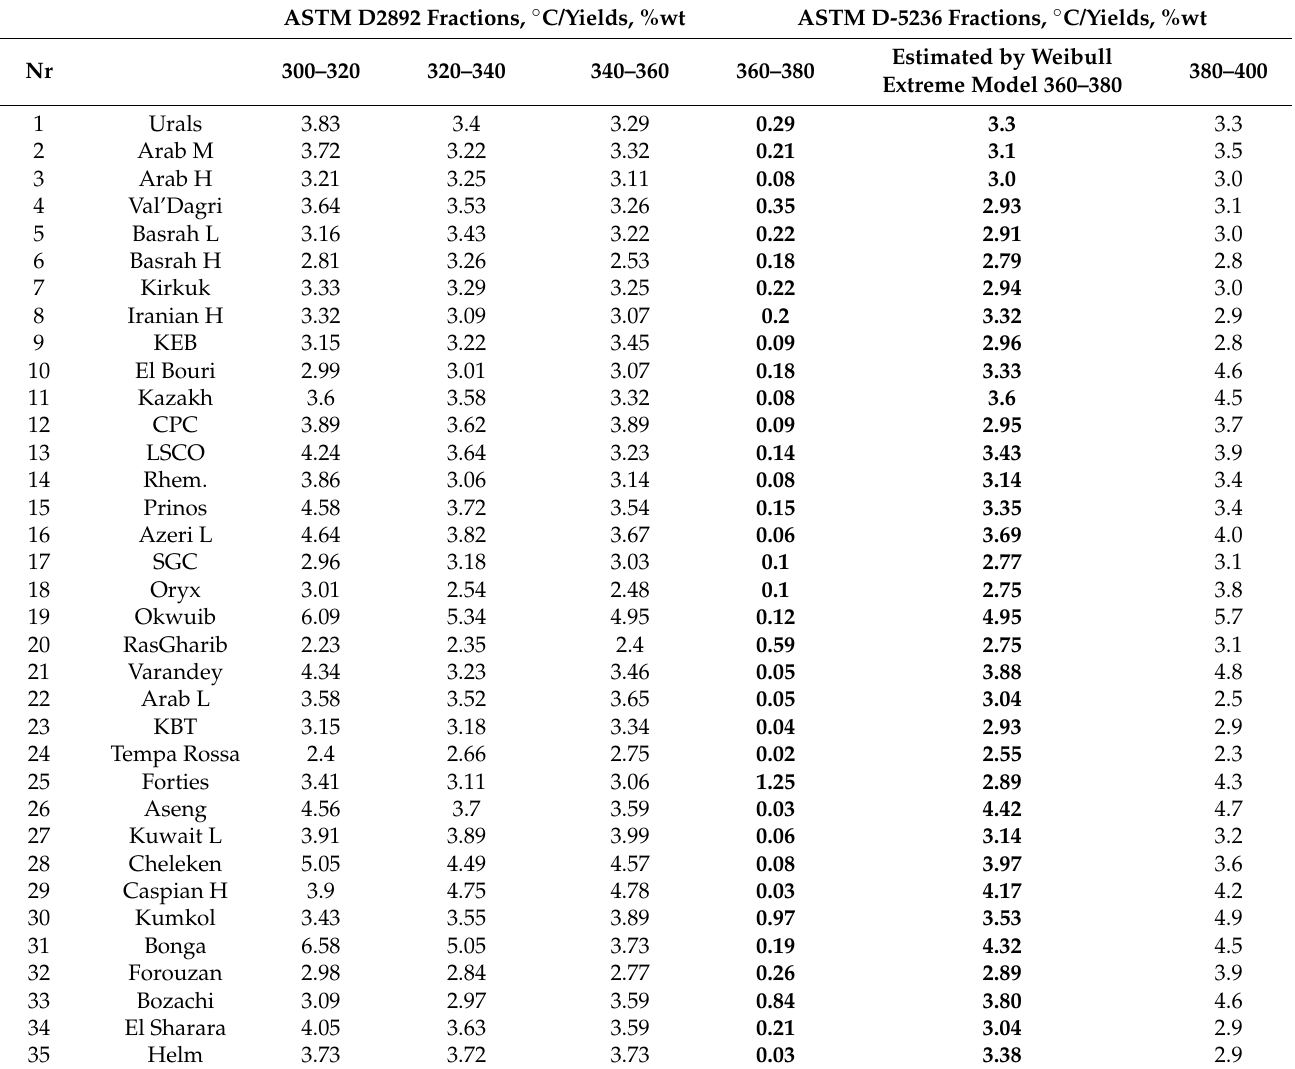
Table 4. 20 ◦ C fraction yields of crude oil TBP curve close to the boundary 360–380 ◦ C gap fraction. ASTM D2892 Fractions, ◦ C/Yields, %wt ASTM D-5236 Fractions, ◦ C/Yields, %wt